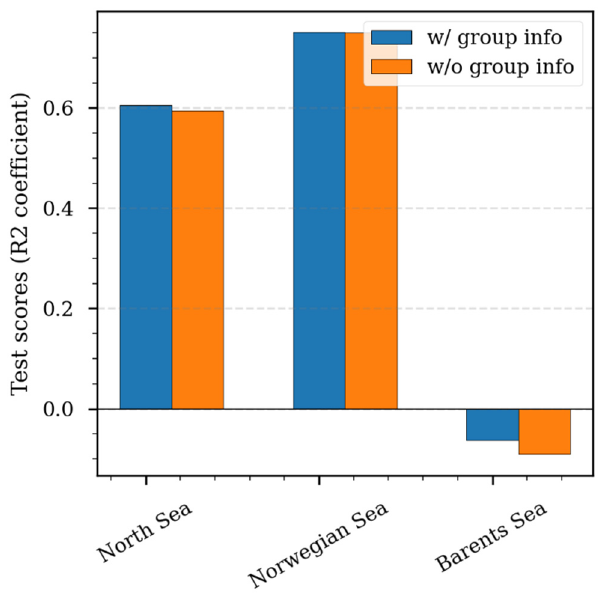
Figure 11. Test scores for each of the three geographical areas using the random forest (RF) machine learning algorithm.